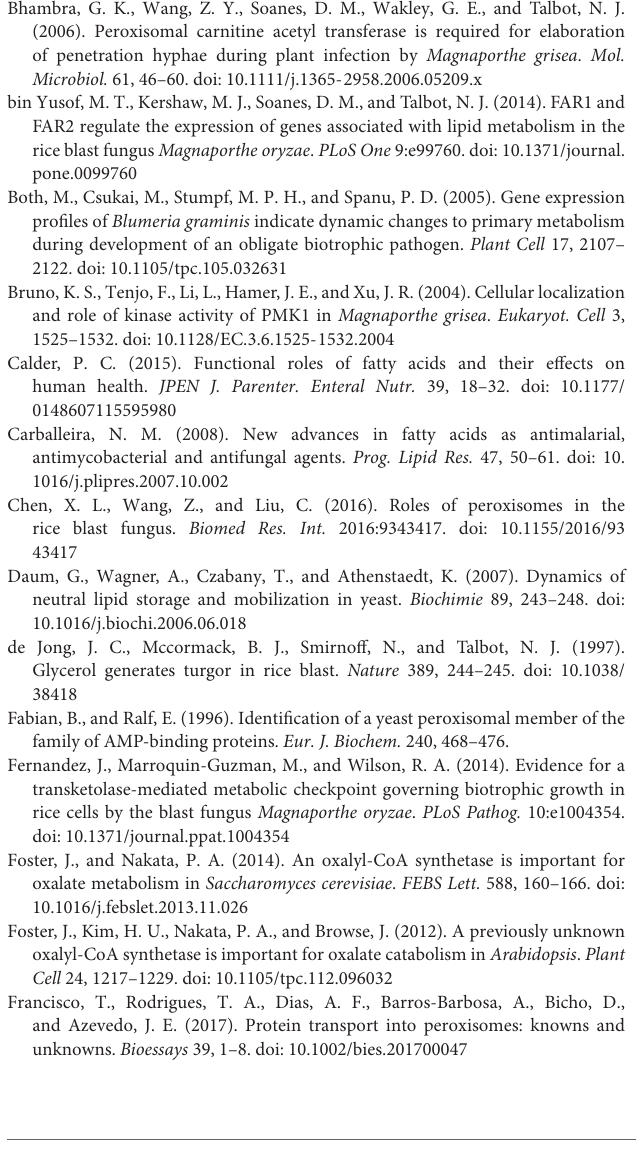
gene knockout mutants were verified by Southern blot analysis with probe 1 (gene fragment) and probe 2 ( HPH ), respectively. The genomic DNA was digested with Eco RI. Supplementary Figure 2 | MoPcs60 is not involved in scavenging host-derived ROS. (A) DAB staining to visualize infection hyphae of the wild-type Guy11, (cid:49) Mopcs60 mutant, and the complemented transformant MoPCS60-C at 24 hpi in infected cells. Bar = 100 µ m. (B) Number of no reddish-brown precipitate in infected cells was counted and analyzed. Error bars represent the standard deviations of the three replicates. Supplementary Figure 3 | MoPcs60 is not necessary for lipid droplets degradation and glycogen translocation during appressorium development. (A) Lipid droplets of conidia and appressoria were stained by Nile red at different time points and observed under a fluorescence microscope. Error bars represent the standard deviations of three replicates. Bar = 20 µ m. (B) Glycogen deposits of conidia and appressoria were stained by iodine solution at different time points and observed under a fluorescence microscope. Error bars represent the standard deviations of three replicates. Bar = 20 µ